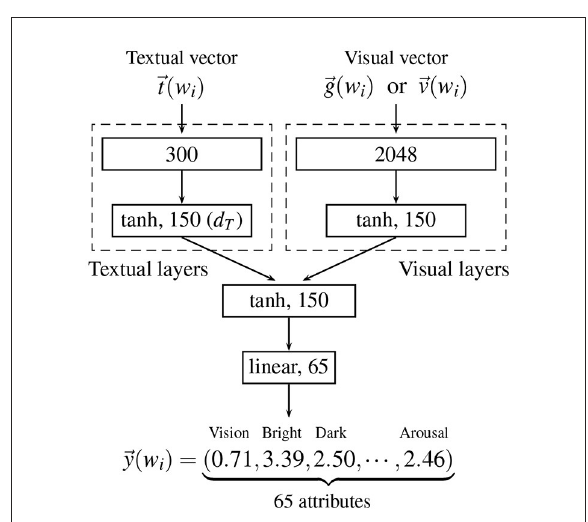
FIGURE2 The neural network used for predicting Binder et al.’s (2016) conceptual representation E y ( w i ) of a word w i from textual and/or visual vectors in the evaluation experiment. The visual vector used as input is either E g ( w i ) (for the indirect grounding and indirect visual models) or E v ( w i ) (for the hybrid, dual-coding, and visual